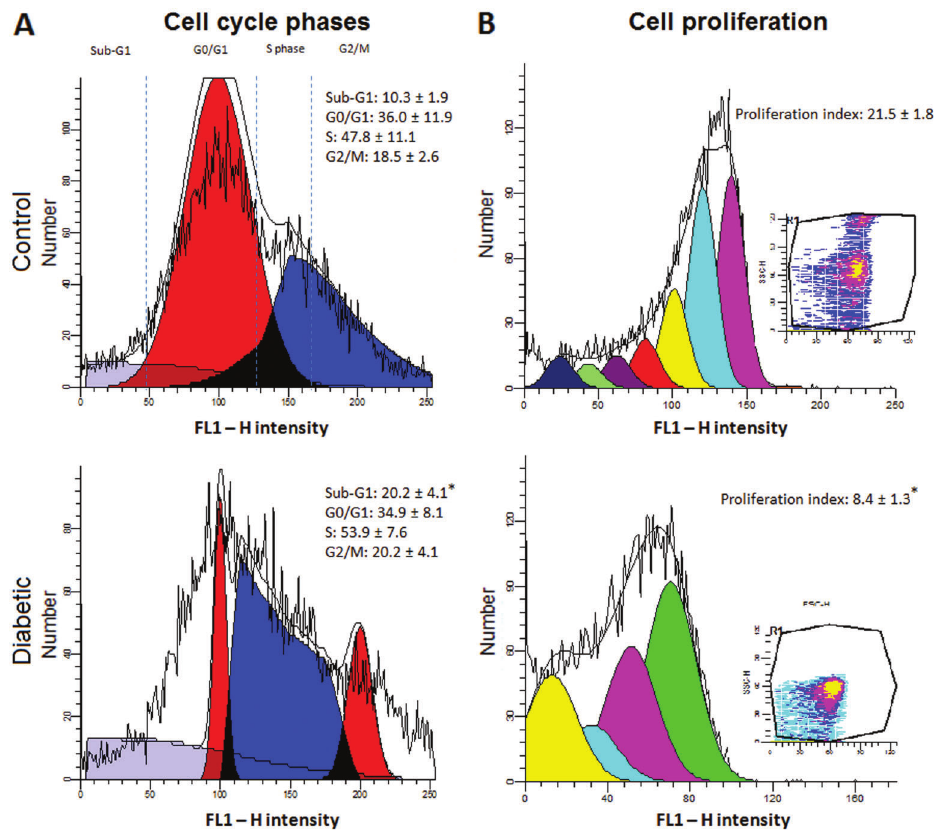
Figure 3. A , Cell cycle analysis showed the same variable distribution of visceral yolk sac (VYS) cells in all phases for both groups, except for the greater number of sub-haploid cells in the diabetic group. B , VYS cells showed a lower proliferation index in the diabetic group than in the control group. Results are reported as the means ± SE of cells collected from fi ve yolk sacs per animal of the control (n=5) and diabetic groups (n=5) analyzed in duplicate. *P o 0.05 (Student ’ s t